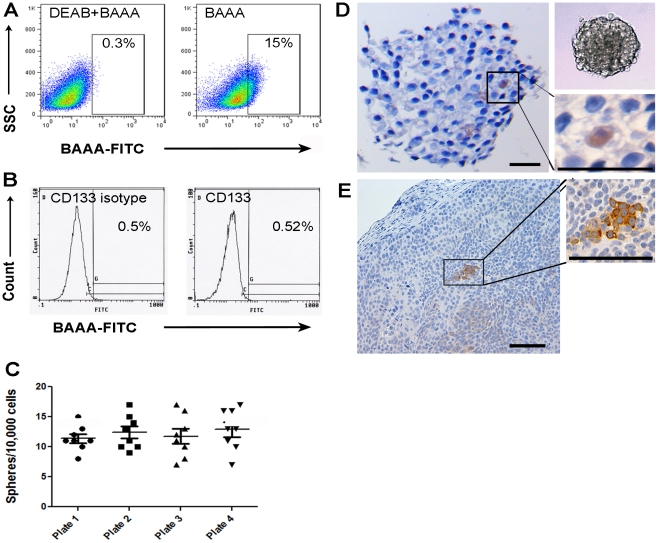
ALDH activity and expression in L3.6pl pancreatic cancer cells.(A) Representative example of L3.6pl cells stained with Aldefluor reagent with and without the DEAB inhibitor as described in Materials and Methods. Analysis by flow cytometry demonstrated high ALDH activity in approximately 16% of cells. (B) L3.6pl cells stained with directly conjugated CD133 antibodies failed to reveal a significant CD133+ population relative to isotype controls. (C) L3.6pl cells form spheres after plating on ultra-low attachment plates (average of 12 spheres/10,000 cells). (D) Cross sections of spheres were made and stained for ALDH1. A minority of cells contained within spheroids demonstrated strong ALDH1expression. (E) Staining for ALDH1 in sections of indirect xenograft tumors formed from L3.6pl cells in nude mice. Note small clusters of ALDH positive cells. Scale bar  = 20 µm (D), 50 µm (E).